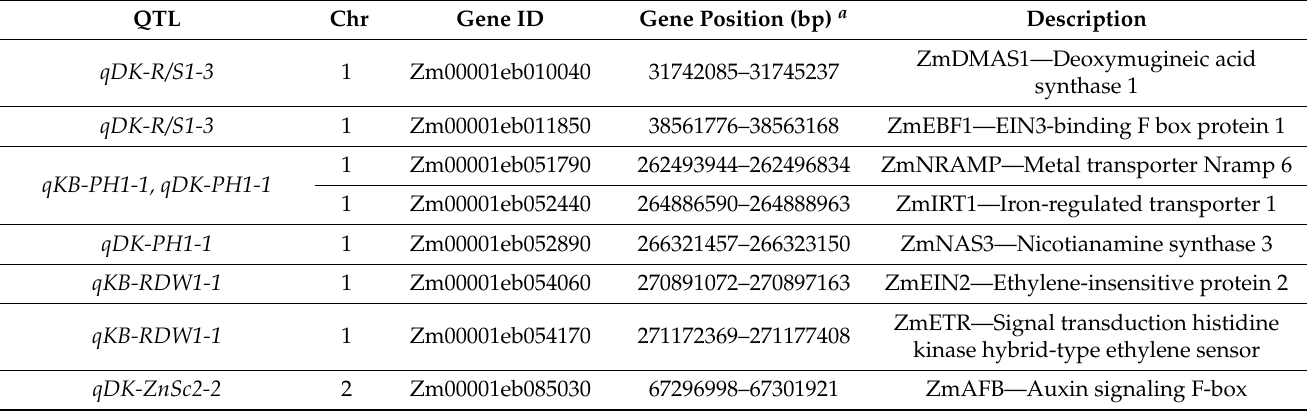
Table 4. The information of candidate genes within the